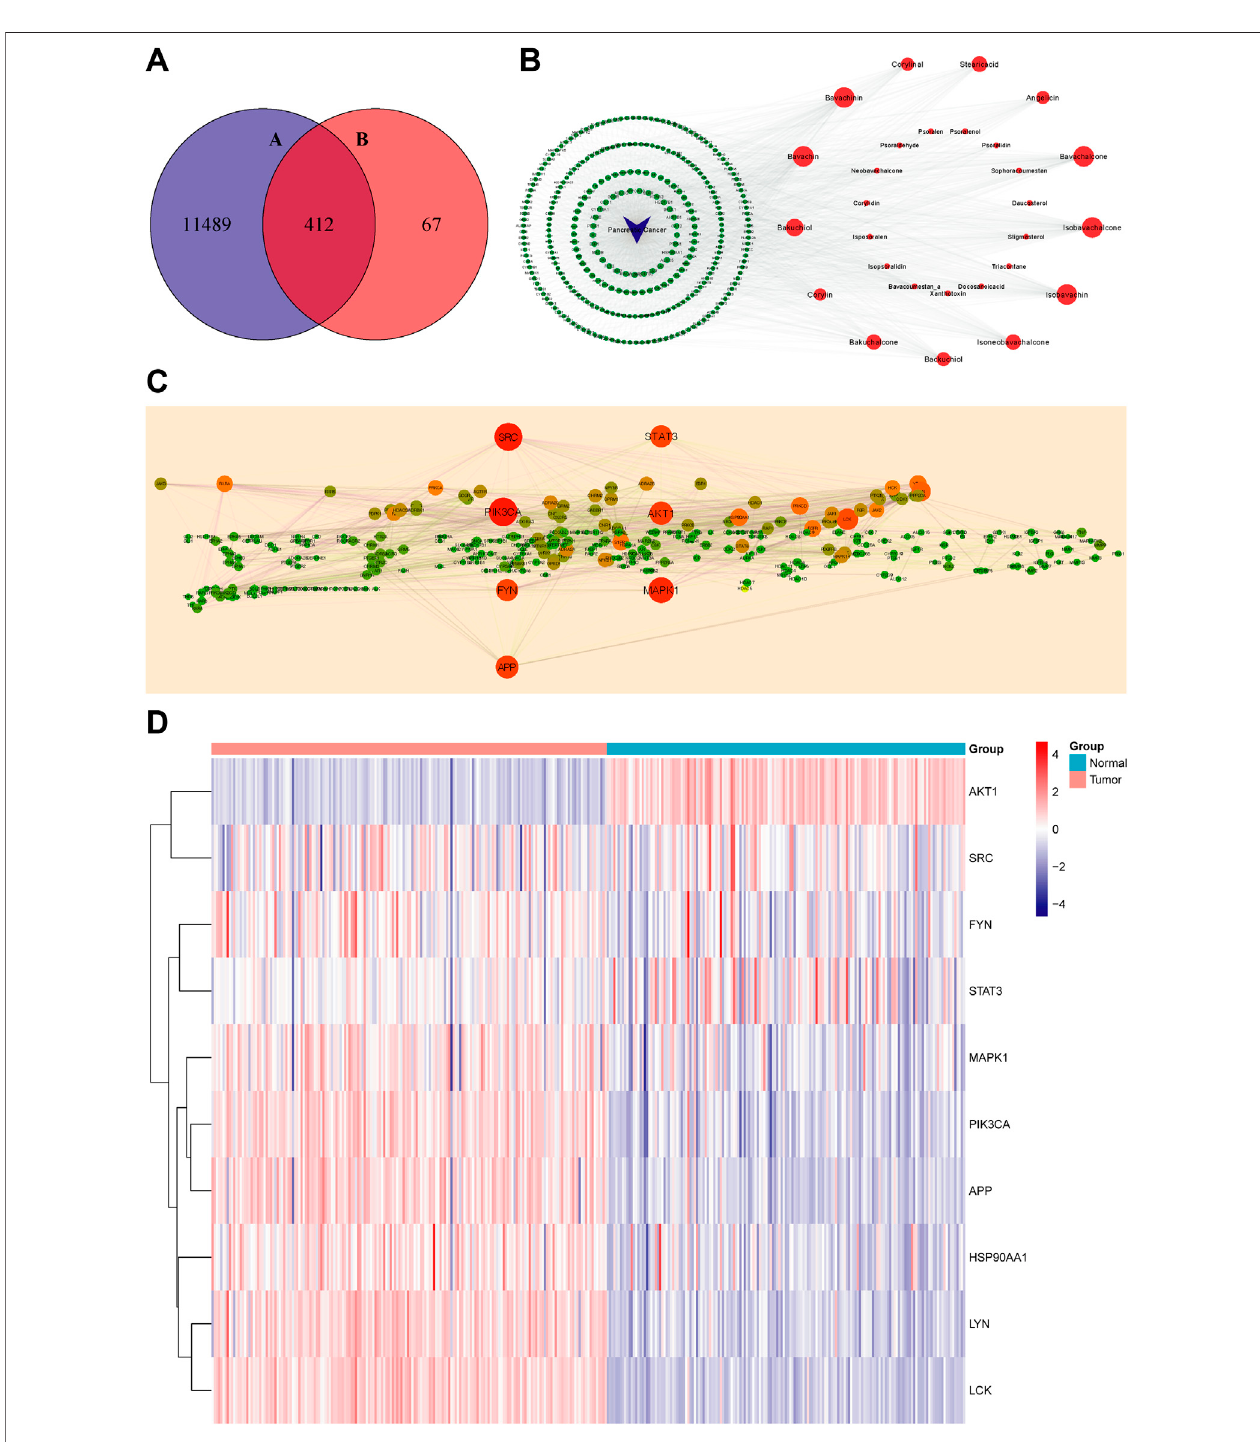
FIGURE2| VirtualscreeningforcoretargetsofPCLagainstpancreaticcancer. (A) OverlappingtargetsofPCLandpancreaticcancer:11,901targetsofpancreatic cancer and 479 targets of PCL components. (B) Compound – disease – target network (red nodes represent PCL components, green nodes represent targets of pancreatic cancer, and blue nodes represent pancreatic cancer. The larger the node, the more important is the node in the network). (C) PPI network of PCL in the treatment of pancreatic cancer (the larger and redder node, the more critical is the node in the network). (D) Expression pro fi le of the 10 core targets between the normal and tumor tissues (blue: low expression level; red: high expression level).